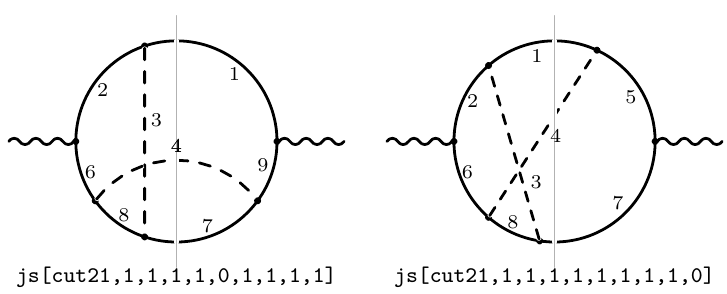
Figure 3 . Prototypes for master integrals of (2 , 1)